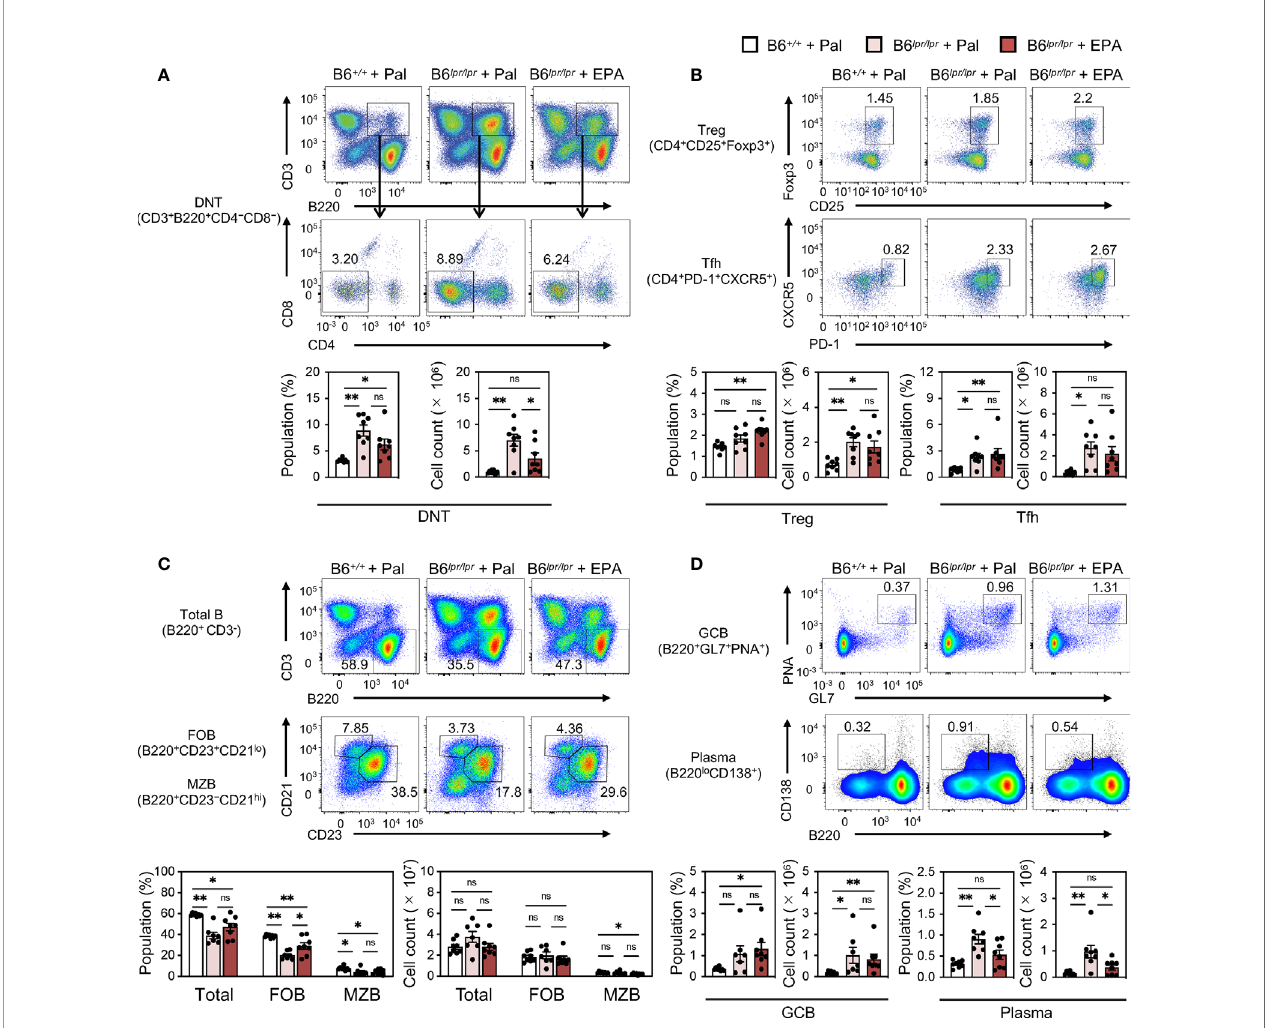
FIGURE 4 | EPA reduces plasma cells in spleen of spontaneous lupus mice. Immunophenotyping of spleen from B6 +/+ mice fed Pal-supplemented diet, B6 lpr/lpr mice fed Pal-supplemented diet, and B6 lpr/lpr mice fed EPA-supplemented diet by fl ow cytometry. Gating strategy is available in Figure S5 . (A) Representative fl ow cytometry plots (top), percentages (bottom, left) and cell counts (bottom, right) of CD3 + B220 + CD4 − CD8 − double negative T cells (DNT) in total spleen cells. (B) Representative fl ow cytometry plots (top), percentages and cell counts (bottom) of CD4 + T cell subsets in total spleen cells. CD4 + CD25 + Foxp3 + regulatory T cells (Treg) and CD4 + PD-1 + CXCR5 + follicular helper T cells (Tfh) were analyzed. (C) Representative fl ow cytometry plots (top), percentages (bottom, left) and cell counts (bottom, right) of B220 + B cell subsets in total spleen cells. Total B220 + CD3 - B cells, B220 + CD23 + CD21 lo follicular B cells (FOB), B220 + CD23 − CD21 hi marginal zone B cells (MZB) were analyzed. (D) Representative fl ow cytometry plots (top), percentages and cell counts (bottom) of B cell subsets in total spleen cells. B220 + GL7 + CD95 + germinal center B cells (GCB) and B220 lo CD138 + plasma cells (Plasma) were analyzed. B6 +/+ + Pal, n = 9 ; B6 lpr/lpr + Pal, n = 7 ; B6 lpr/lpr + EPA, n = 8. Data shown are mean value ± SEM of representative experiments at least twice independently. Statistical analysis was performed with Dunn ’ s test ( D : GCB) or Tukey ’ s test (if not otherwise stated). *p < 0.05; **p < 0.01; ns, not signi fi cant. See also Figure S5 and S6